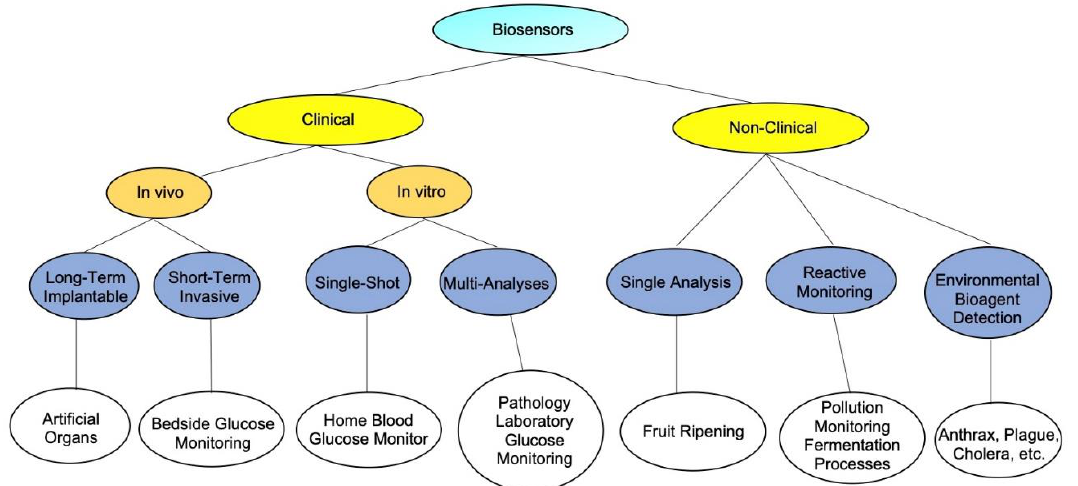
Figure 2: Applications of Biosensors and the different sectors they are used in [9].